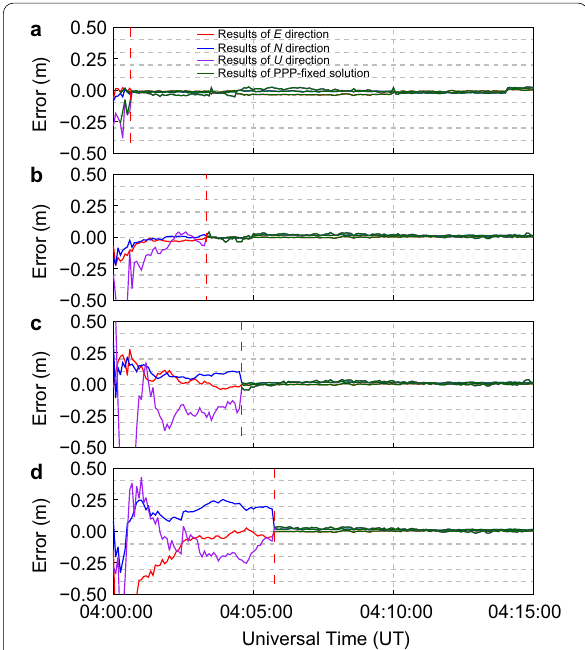
Fig. 7 The convergence time of the ionospheric delay corrections with an error of a smaller than 0.5 TECU, b 1 TECU, c 3 TECU, and d 5 TECU as optimum variance, respectively